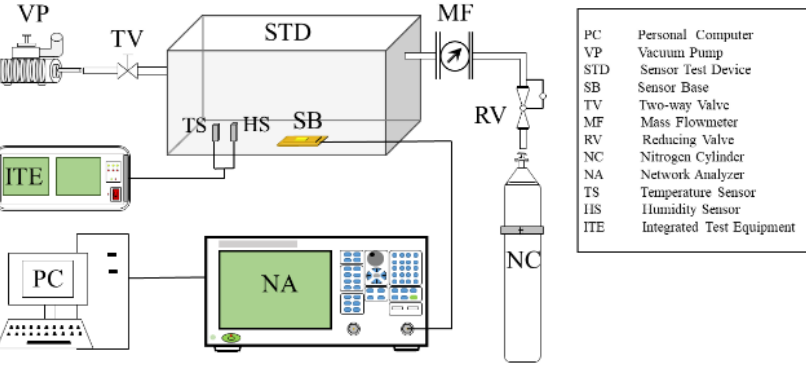
Figure 6. Performance testing system of SAW